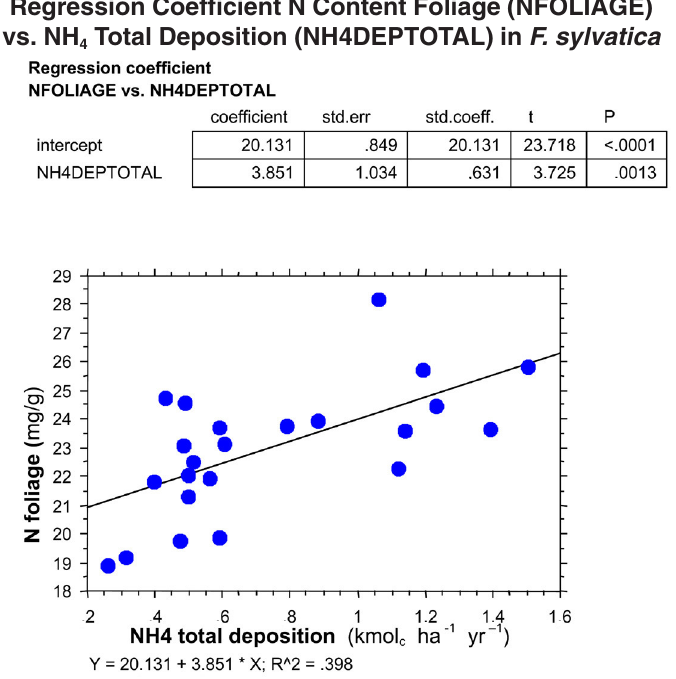
Regression Coefficient N Content Foliage (NFOLIAGE) vs. NH Total Deposition (NH4DEPTOTAL) in F. 4